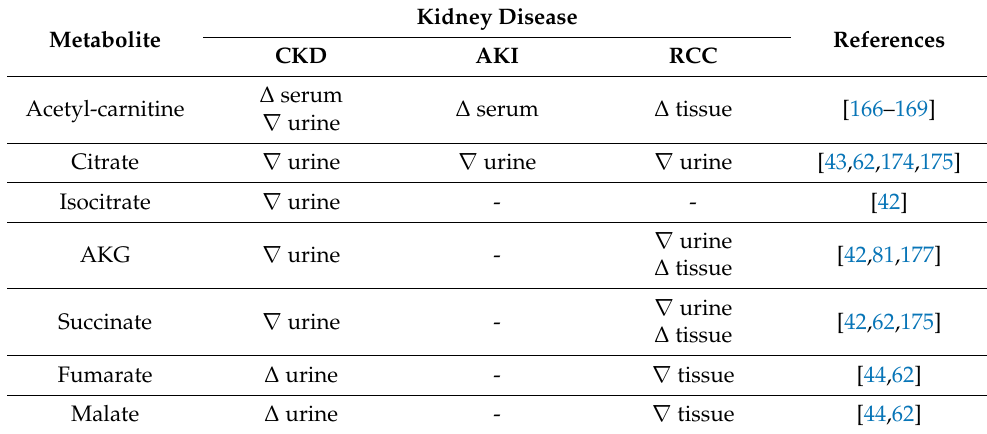
Table 1. TCA cycle metabolites alterations in kidney diseases with potential use as